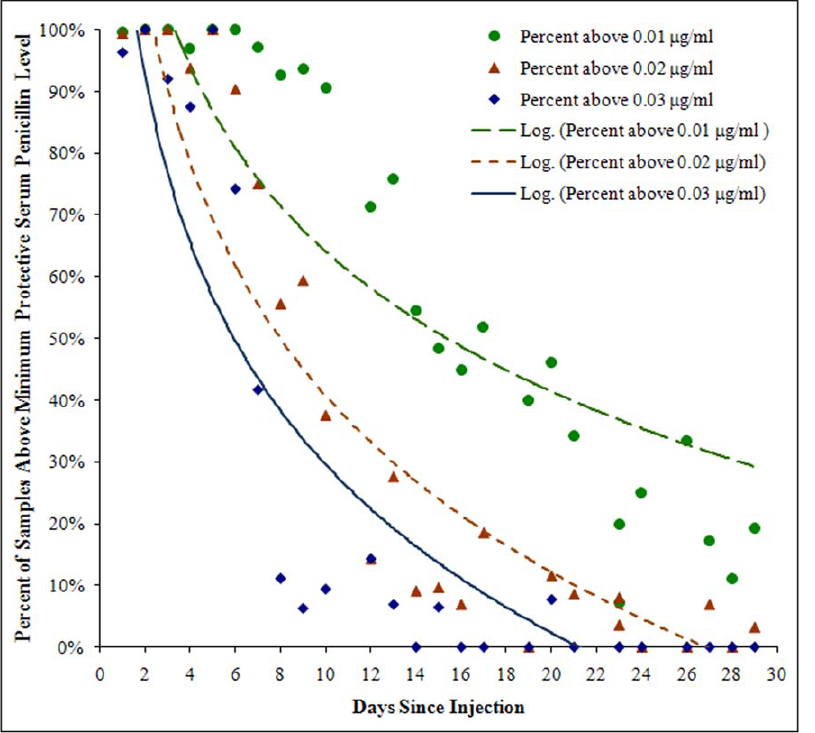
Figure 2. Percentage of subjects whose penicillin G serum level was greater than three proposed minimum protective versus day since injection. Logarithmic trend-line estimates are shown for each protection level. As days progress, the percentage of values above minimum protective per day continually decreases with some day-to-day variation. (Note:day 21 outlier removed from calculation of percentages; see text.)